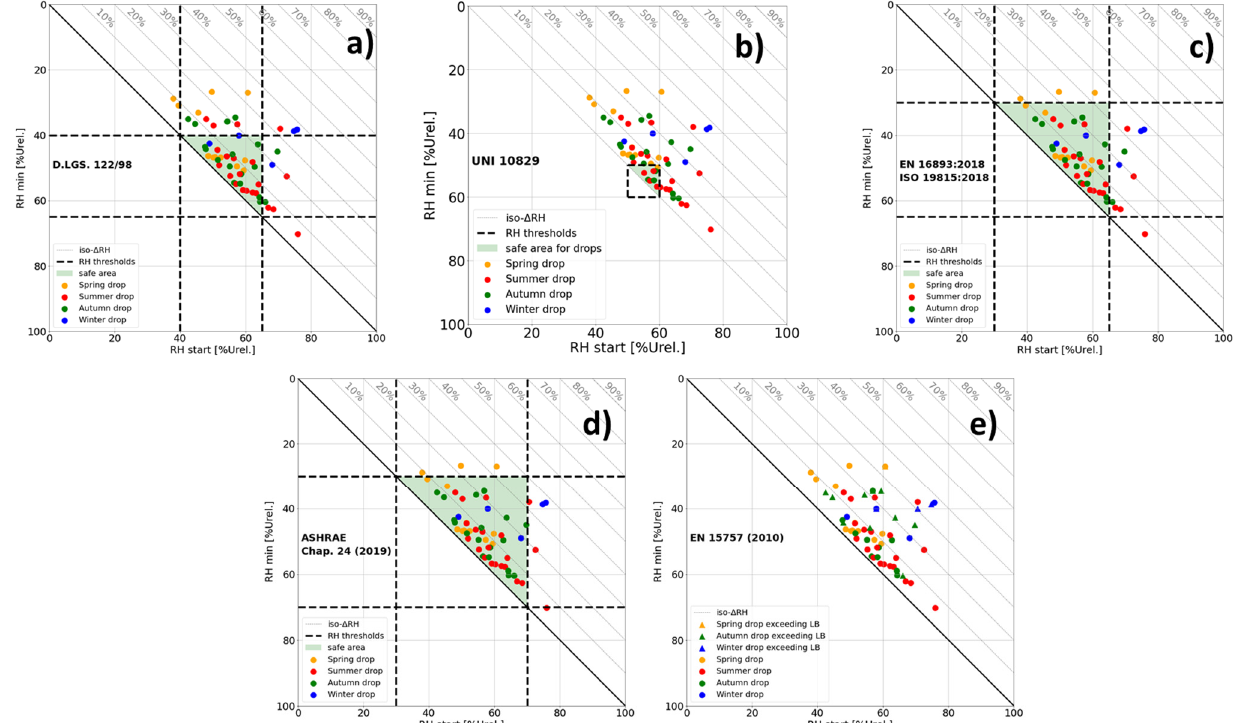
Figure 7. Scatterplots of the drops of RH identified in Heddal church through the MoD strategy as originally explained in [20], together with the thresholds defined by the standards: D. Lgs. 122 art. 150 par. 6 ( a ), UNI 10829 ( b ), EN 16893 and ISO 19815 ( c ), ASHRAE Chap. 24 ( d ), EN 15757 ( e